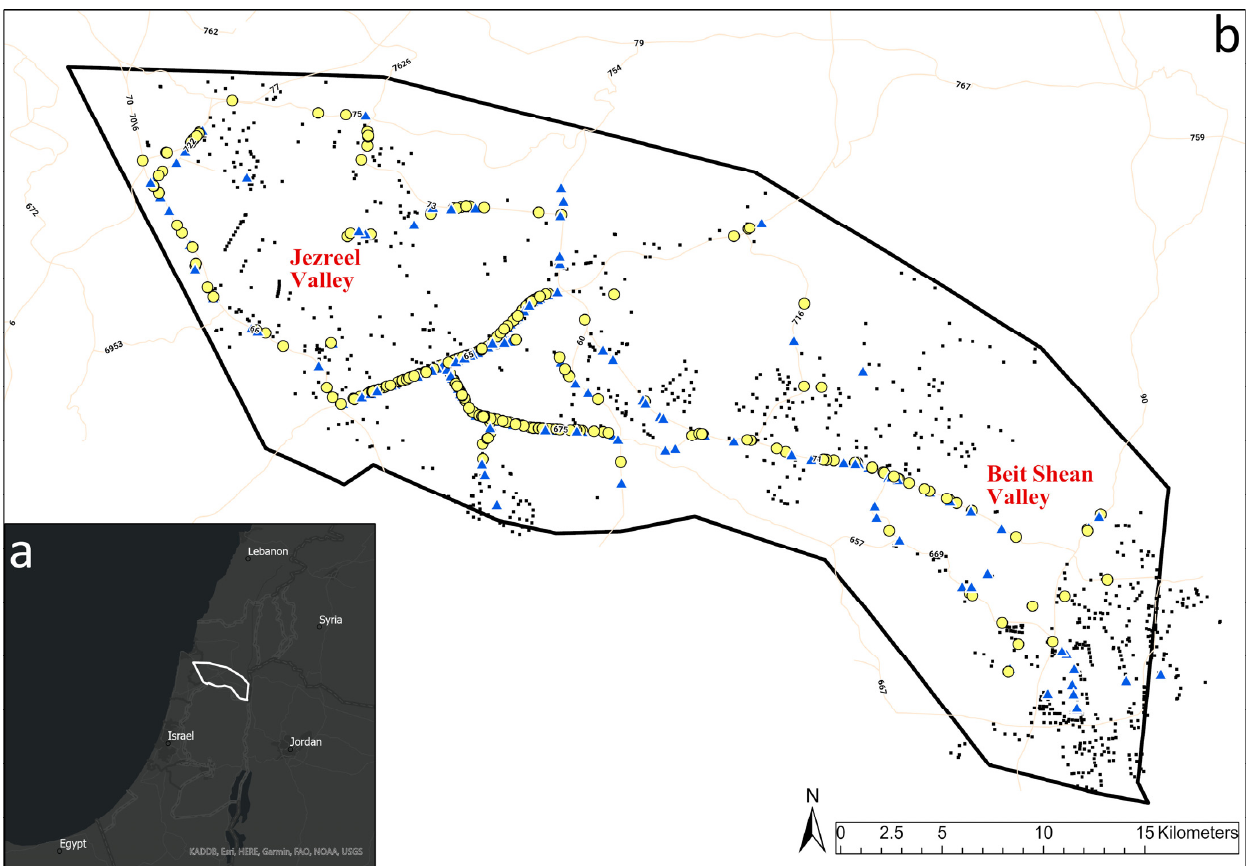
Figure 1. The map on the bottom left ( a ) shows the location of the study site in the Beit Shean and Jezreel Valleys in northern Israel and the neighboring countries. The study site is outlined in white on a black background. The larger zoomed-in map ( b ) of the study site with the white background shows the locations of barn owl nest boxes as black dots and the locations of barn owl roadkills collected from 2009 to 2017 as yellow circles (without rings) and blue triangles (with ring recoveries).